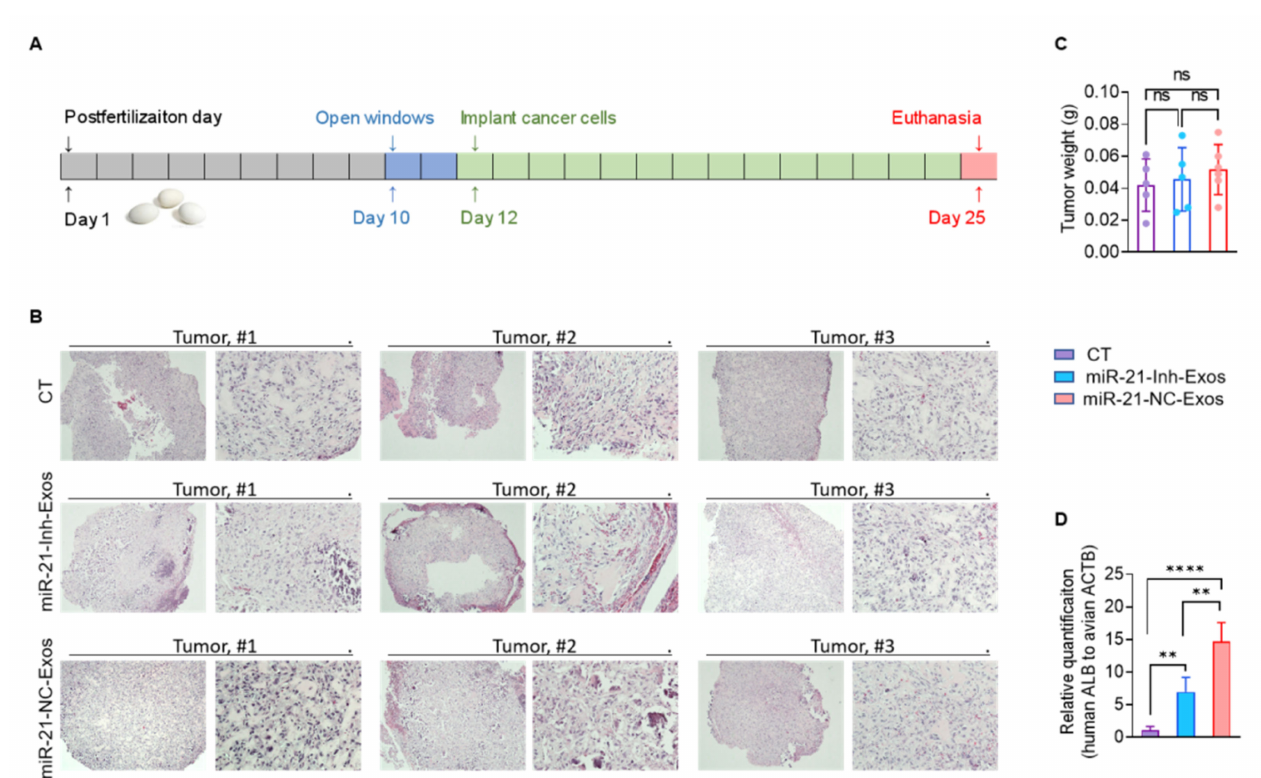
Figure 5. MiR-21-5p in M2-Exos directs RCC aggressive behaviors in vivo. ( A ) Schematic diagram of the timeline of CAM xenograft implantation. Three groups of 786-O tumor cells were implanted on CAMs following treatment with exosomes-free media (the control group), miR-21-Inh-Exos, or miR-21-NC-Exos. ( B ) H&E stains of three representative CAM-derived tumors from each group are shown. Magnification: 40 × , 200 × , for each tumor sample. ( C ) The tumor weights of harvested CAM tumors from each group. ( D ) qPCR for human ALB in embryonic livers normalized to avian ACTB. ** p < 0.01, **** p < 0.0001, ns: not